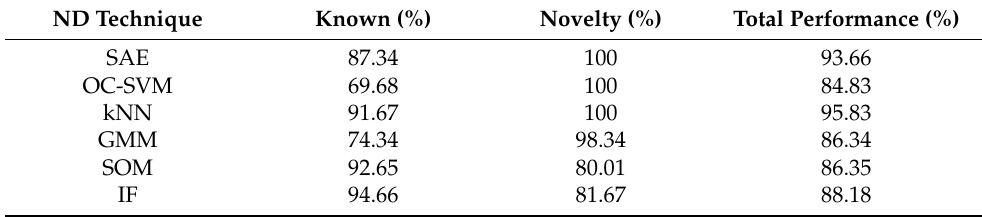
Table 12. Numerical results of the novelty detection obtained for the third case study of the WPG_DS.